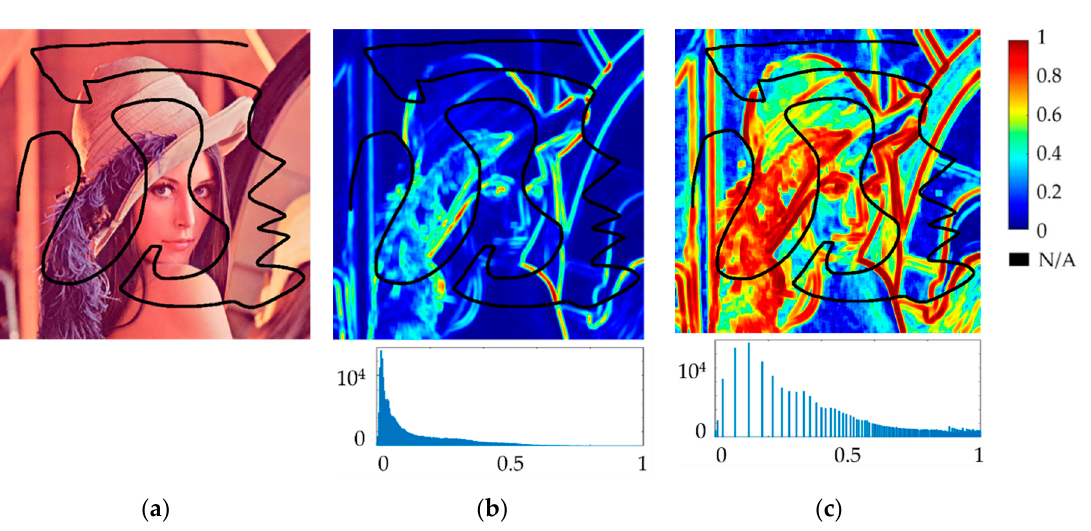
Figure 3. ( a ) Incomplete image Lena, the missing area is depicted in black; ( b ) map / histogram of (cid:101) σ ( Φ ) of Lena (non-equalized); ( c ) map / histogram of equalized (cid:101) σ ( Φ ) of Lena, defined as the nonuniformity T ( Φ ) in our